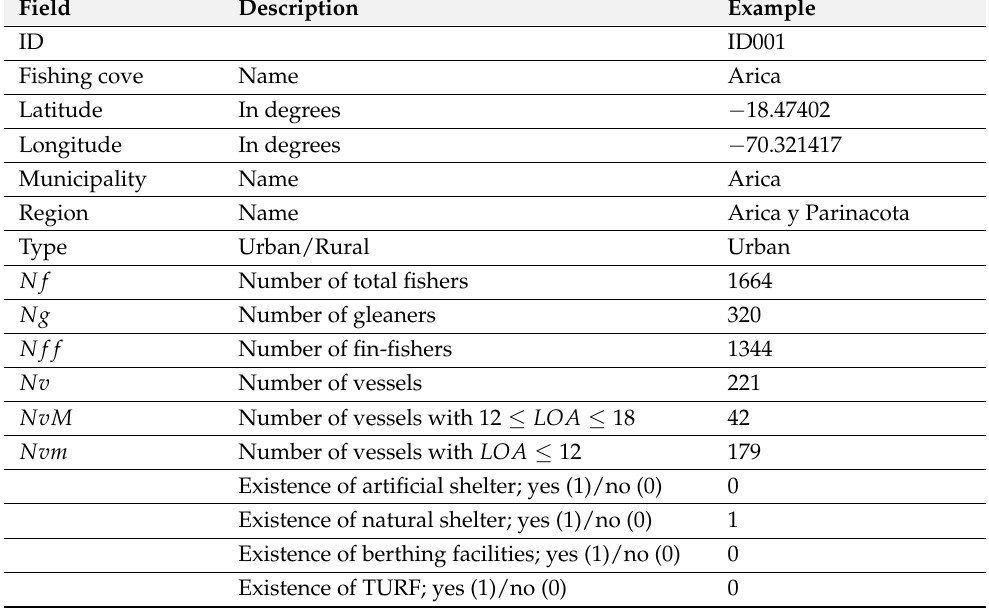
Table 3. Fields used in the inventory for each fishing cove, and their values for the example of Arica cove. Data for all fishing coves can be downloaded from ARClim by clicking the button “Exportar datos”, at the top right corner of the site https://arclim.mma.gob.cl/atlas/view/caletas_pescadores/ (accessed on 12 October